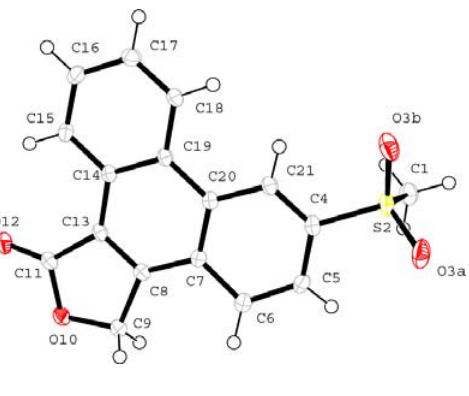
Figure 5. The asymmetric unit of I showing the numbering scheme (the hydrogen numbering has been omitted for